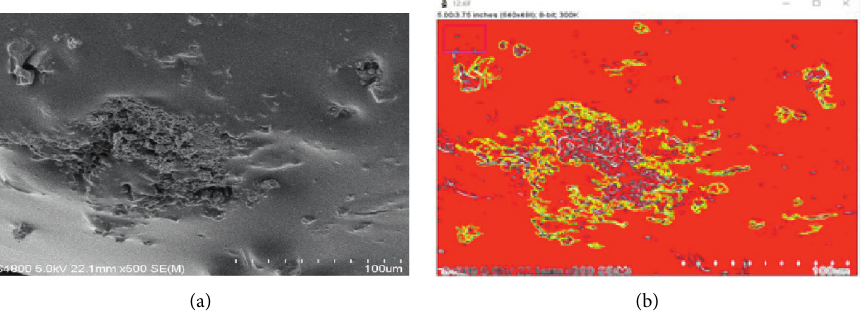
Figure 9: ImageJ software image-recognition process of the asphalt film peeling area. (a) Original SEM image. (b) Peeling surface recognition after ImageJ image